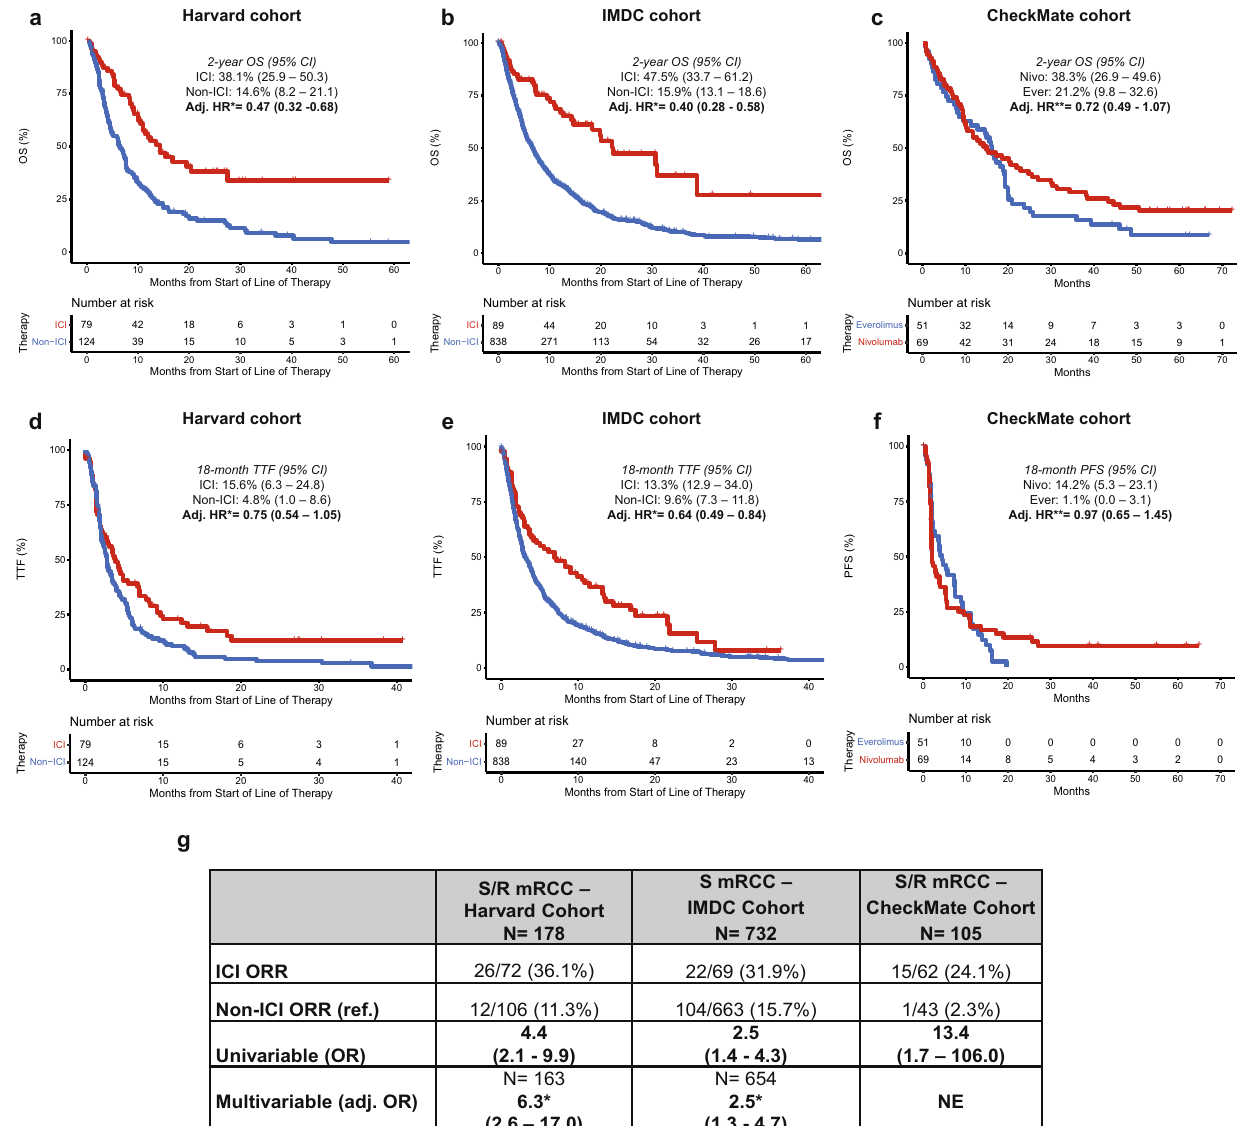
Fig. 3 Improved clinical outcomes of S/R RCC tumors on immune checkpoint inhibitors across clinical trial and real-word cohorts. OS on ICI compared to non-ICI in the a Harvard, b IMDC and c CheckMate S/R RCC cohorts. TTF on ICI compared to non-ICI in the d Harvard and e IMDC S/R RCC cohorts and f PFS in the CheckMate S/R RCC cohort. g Summary table of overall response rate (among evaluable patients) on ICI compared to non-ICI in patients with S/R RCC across the Harvard, IMDC, and CheckMate cohorts. 95% CI: 95% Con fi dence Interval; Adj. Adjusted; Ever: Everolimus; HR: Hazard Ratio; ICI: Immune Checkpoint Inhibitor; IMDC: International Metastatic Renal Cell Carcinoma Database Consortium; Nivo: Nivolumab; NE: Not Evaluable; OS: Overall Survival; S/R: Sarcomatoid/Rhabdoid. *Adjusted for IMDC (International Metastatic Renal Cell Carcinoma Database Consortium) risk groups, line of therapy, and background histology. **Adjusted for MSKCC (Memorial Sloan Kettering Cancer Center) risk